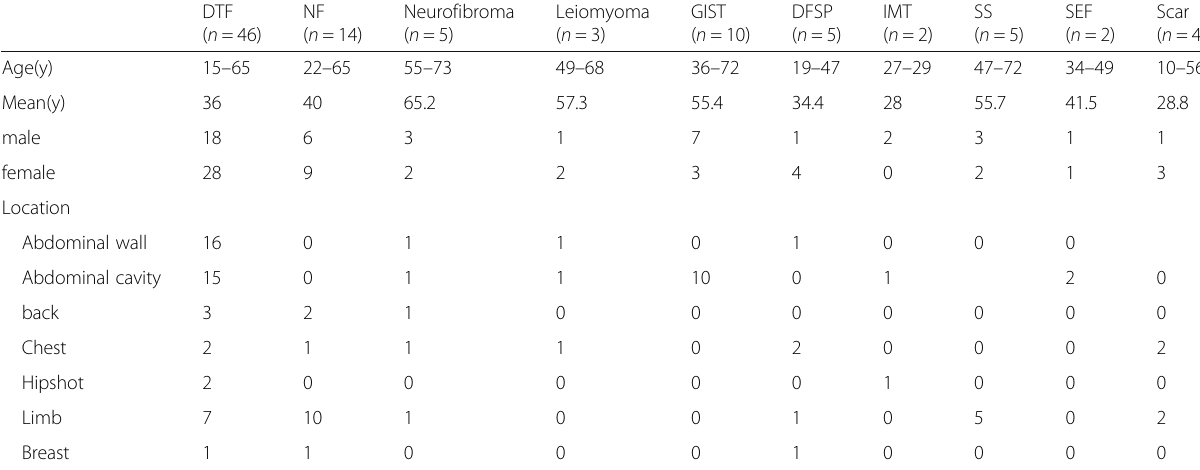
Table 1 Patient clinicopathologic